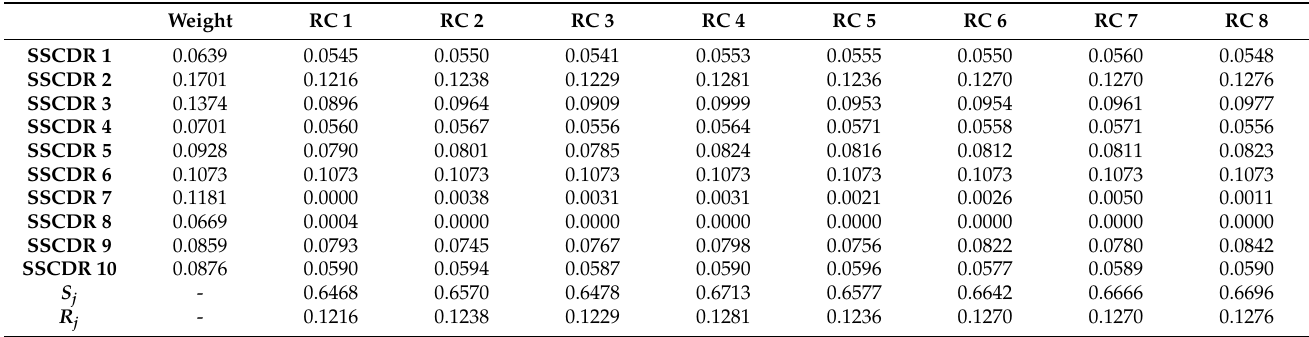
Table 11. Results of group utility S j and individual regret R j .